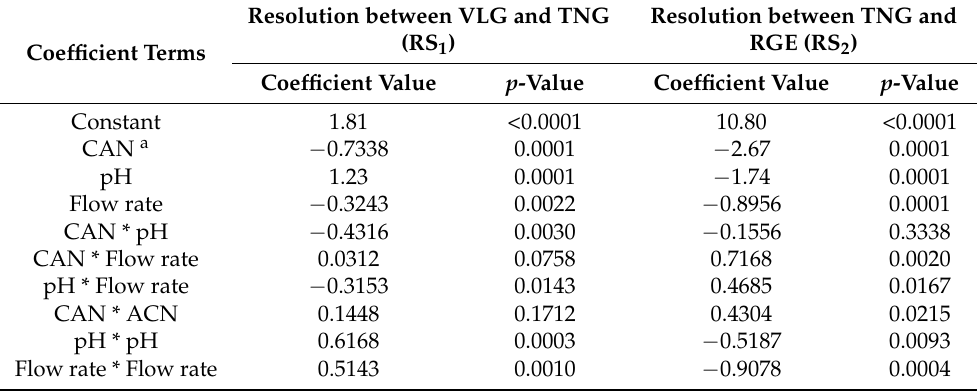
Table 2. Quadratic equation coefficients with related probability values ( p -values) for peak